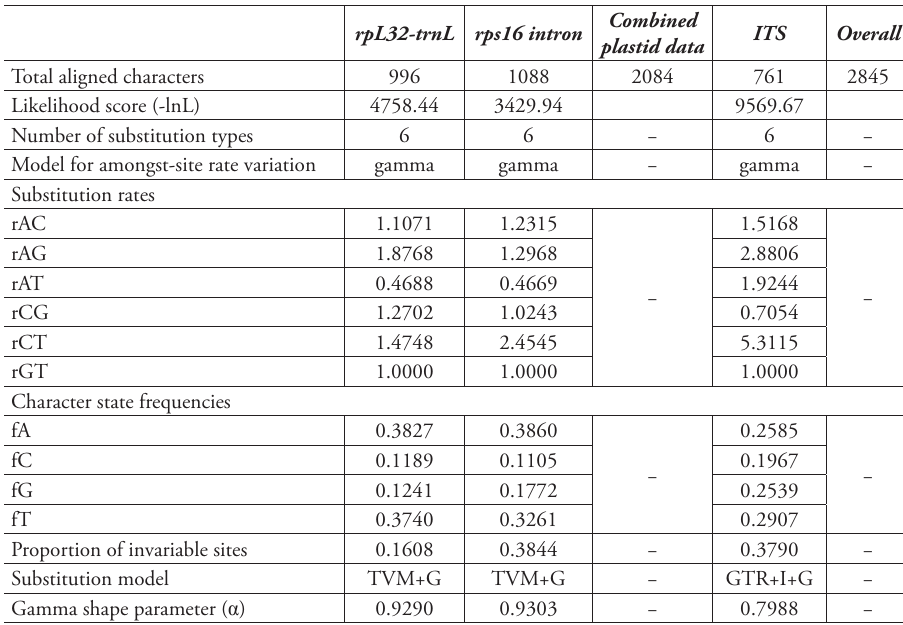
Table 2. Characteristics of the three regions, rpL32-trnL , rps16 intron and ITS and parameters used in Bayesian analyses indicated by Akaike Information Criterion